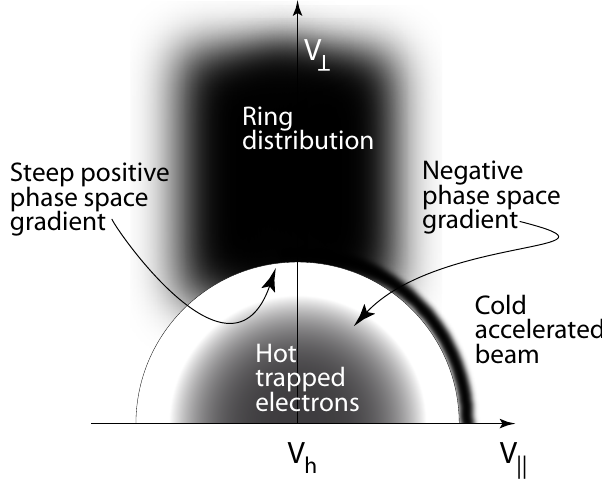
Fig. 9. The idealised circular hole model as seen in the hole-centred reference frame in momentum space as has been translated from the simulations in Fig. 7 into an instantaneous snapshot of one well de- veloped hole. In the stationary frame the hole centre is at parallel hole velocity V h ∼ V R . The fast cold beam that arises at the high ve- locity side of the hole is indicated. Also indicated is the hot trapped distribution. The hole has pushed the ring distribution away from its location. Phase-space velocity gradients evolve along the hole boundaries. The outer boundary of the hole shows a steep positive gradient, while the interior of the hole has a weak negative velocity gradient. Translated into the electron cyclotron maser mechanism this implies a strong emission of radiation into perpendicular direc- tion in the hole frame from the positive gradient located near the electron cyclotron frequency, and an adjacent absorption band lo- cated at higher